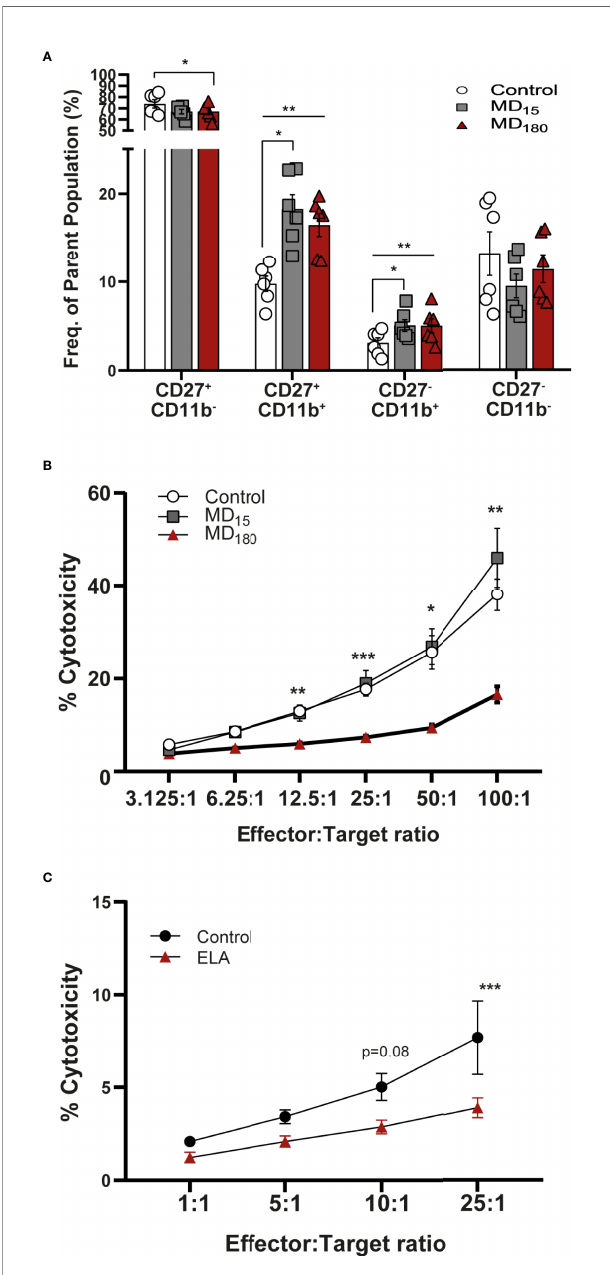
FIGURE 4 | Early life separation induces functional changes in rat and human NK cells. (A) Maturation state of rat NK cells de fi ned by CD27 and CD11b markers. Cells were gated from CD161a+/Nkp46+ NK cells; (B) Cytotoxic response of rat NK cells to YAC-1 cells; (C) Cytotoxic response of NK cells from institutionalized individuals to K562 cells. Data is presented as mean ± SEM of 6 animals per group or 14 donors per group. Statistics: Two-way ANOVA; *p < 0.05; **p < 0.01; ***p < 0.001. Representative Figures for fl ow data are included in the Supplementary Material